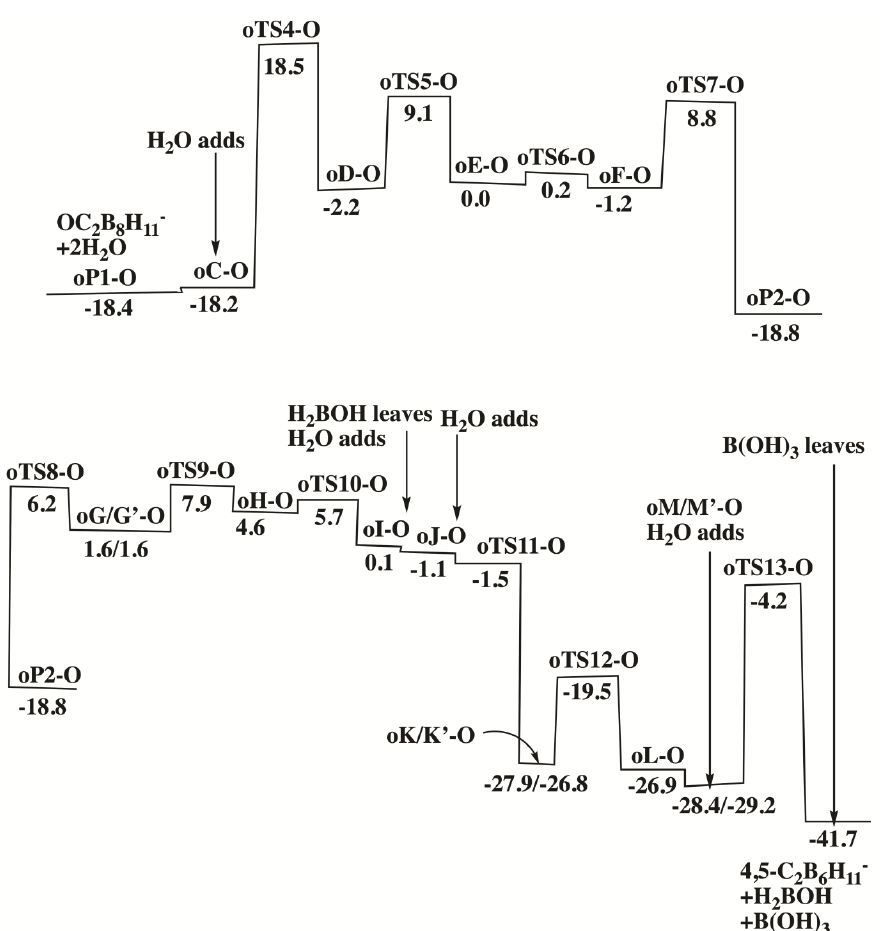
Figure 2. Relative free energies (kcal · mol − 1 ) of the individual stationary points on the Potential Energy Surface (PES) of the reaction of closo -1,2-C 2 B 8 H 10 with OH ( − ) (see Table 1 and Methods for details).